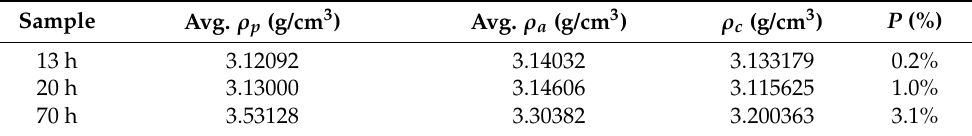
Table 3. Average results of the powder density— ρ p , the calculated density— ρ c , apparent density— ρ a and porosity— P for selected samples of the sintered Mg-Zn-Ca-Pr alloy for samples milled for 13, 20, and 70 h.